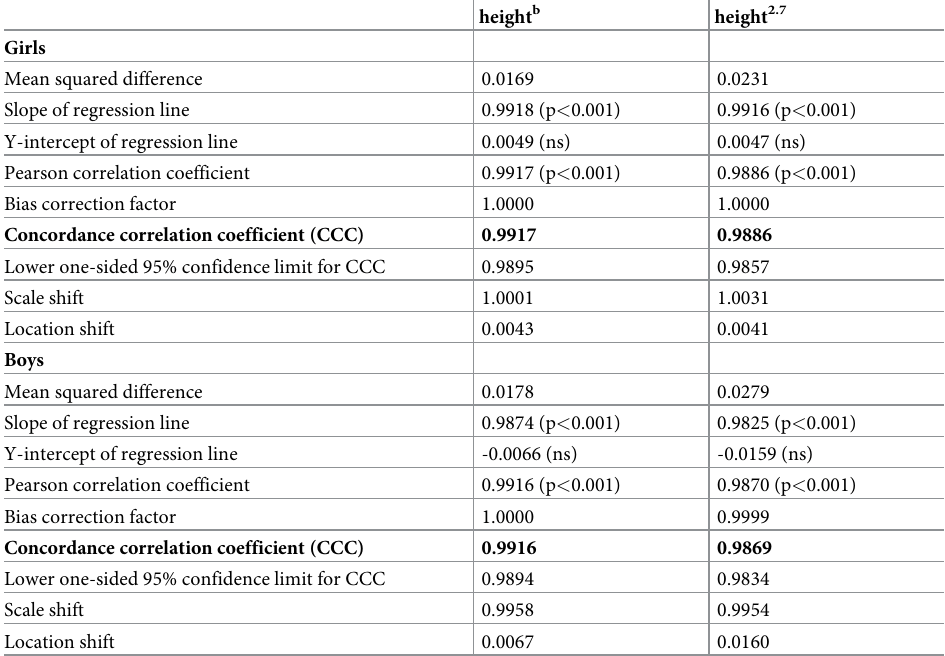
Table 3. Evaluation of the agreement between the allometrically adjusted ratio methods of LVM normalization and the LMS